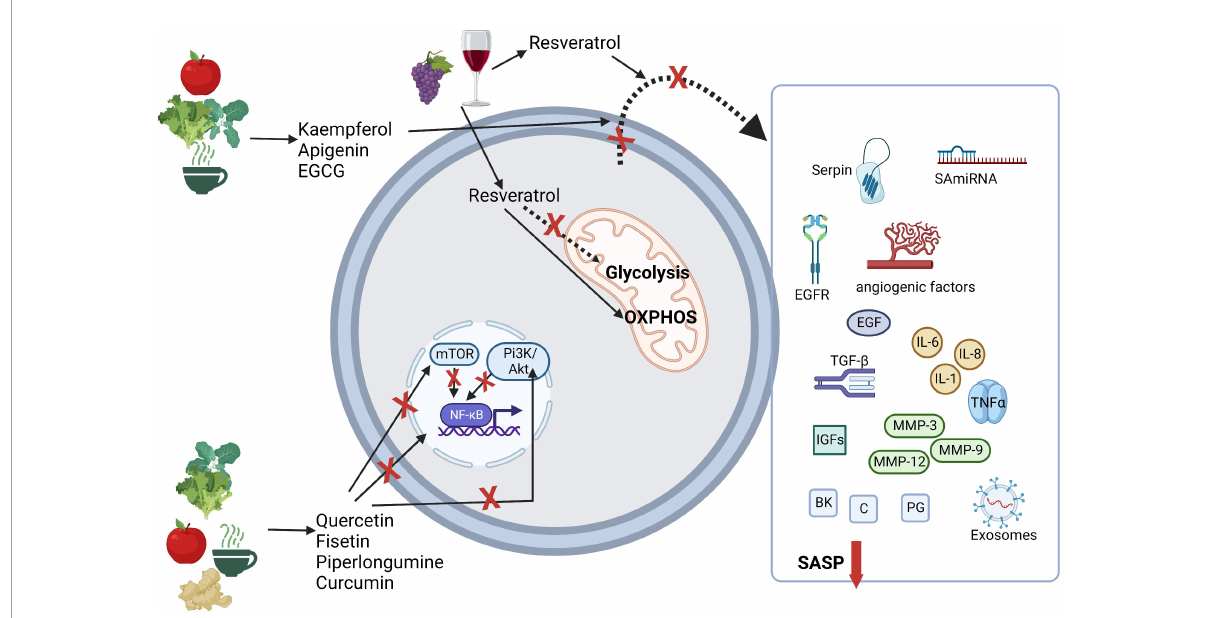
FIGURE3 Possible mechanisms involving nutritional senolytics and senotherapeutics in aging. Akt, protein kinase B; BK, bradykinin; C, ceramides; EGCG, epigallocatechin-3-gallate; EGF, epidermal growth factor; EGFR, epidermal growth factor receptor; IGFs, insulin-like growth factors; IL, interleukin; MMP, matrix metalloproteases; mTOR, mammalian target of rapamycin; NF-kB, nuclear factor- κ B; OXPHOS, oxidative phosphorylation; PI3K, phosphoinositide 3-kinases; PG, prostaglandin; SA-miRNA, senescence-associated microRNAs; TGF, transforming growth factor; TNF, tumor necrosis factor. Created with